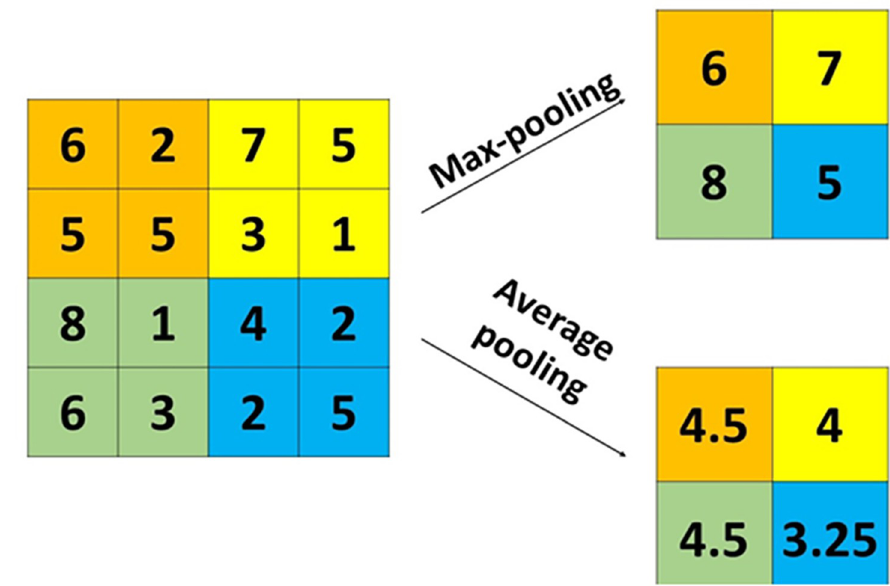
Fig 4. Example of calculating max-pooling and average pooling with filter of size 2X2 and stride